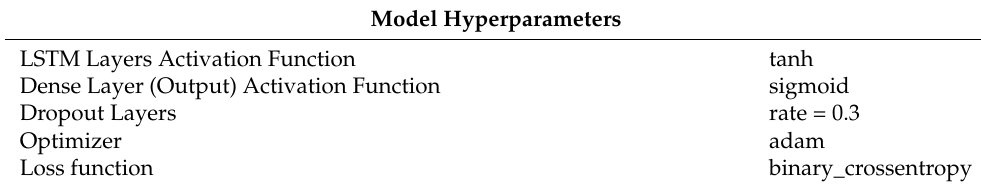
Table 2. LSTM model